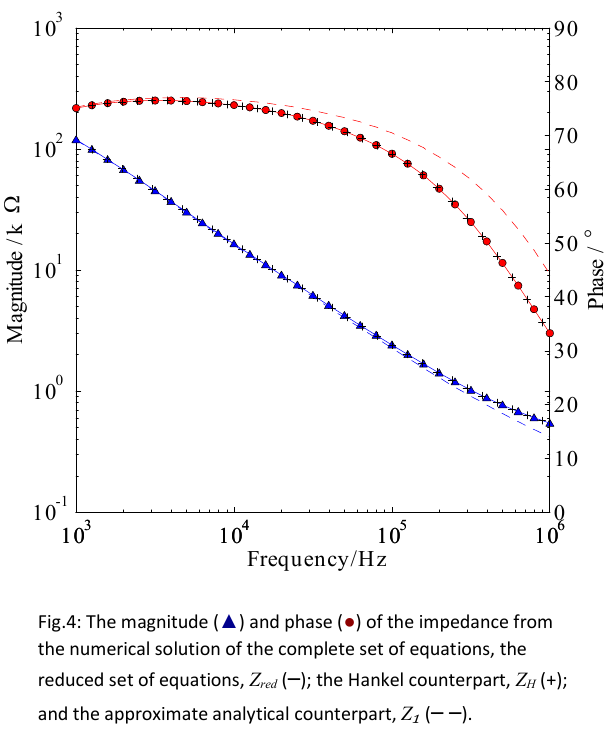
Fig.4: The magnitude ( ▲ ) and phase (●) of the impedance from the numerical solution of the complete set of equations, the reduced set of equations, Z red ( – ); the Hankel counterpart, Z H (+); and the approximate analytical counterpart, Z ₁ ( – – ).